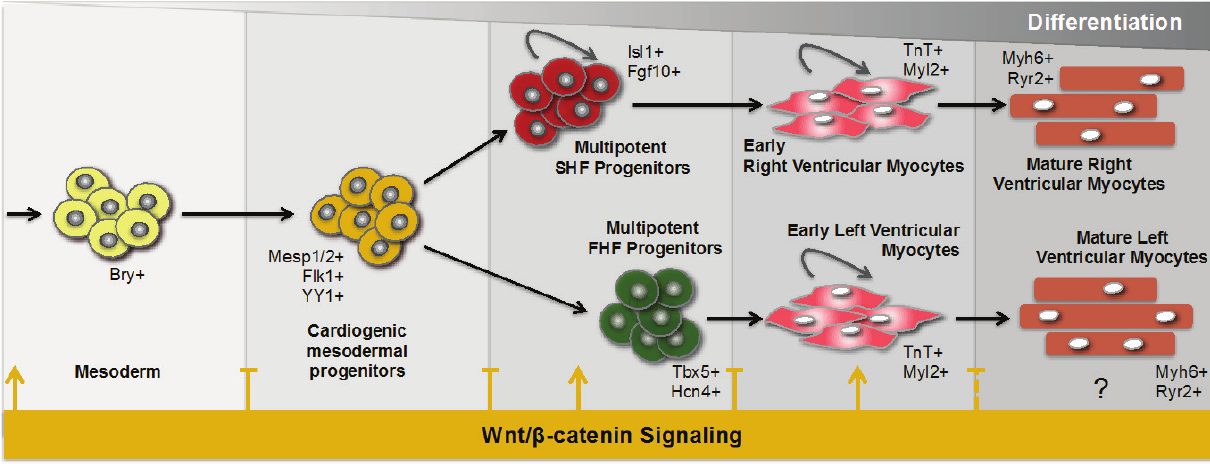
Figure 1. Distinct Phases of Wnt/β -catenin Signaling in Cardiac Development. Stage specific roles of Wnt/β -catenin signaling in proliferation and differentiation of cardiac progenitors and ventricular myocytes. Wnt/β -catenin is spatiotemporally activated or repressed to orchestrate normal cardiac formation; whereas activation of Wnt/β -catenin is required for mesodermal specification [42] , repression of Wnt/β -catenin is mandatory for specification of cardiogenic mesodermal precursors and multipotent progenitors [43]. Subsequently, activated Wnt/β -catenin signaling has proliferative effects in multipotent progenitors [18] and early ventricular myocytes, while the repression of Wnt/β -catenin signaling in this stage promotes further differentiation and exiting of the cell cycle [39]. To date, it is unknown what exact effects Wnt/β -catenin exerts on adult cardiomyocytes. Arrows represent activated Wnt/β - catenin signaling; T’s indicate repressed Wnt/β -catenin signaling; FHF, first-heart-field; SHF,